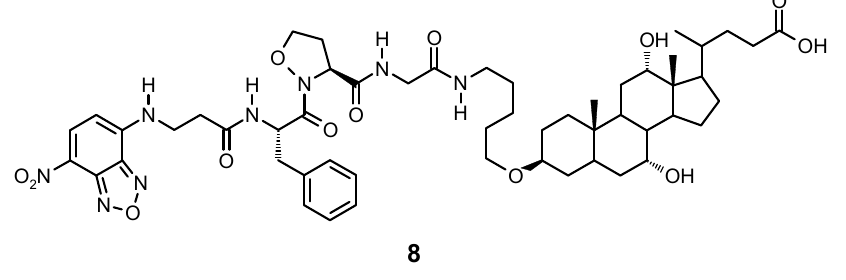
Figure 2. A oxaprolylpeptide-bile acid conjugate